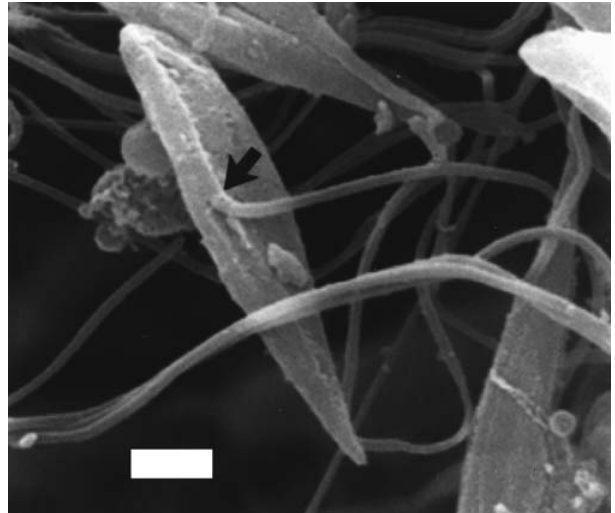
Fig. 17. Scanning electron micrograph of spermatozoon in testis of male Bryconadenos tanaothoros (MCP 30333); ar- row indicates point of exit of the flagellum from the cytoplas- mic collar; bar, 1 µ